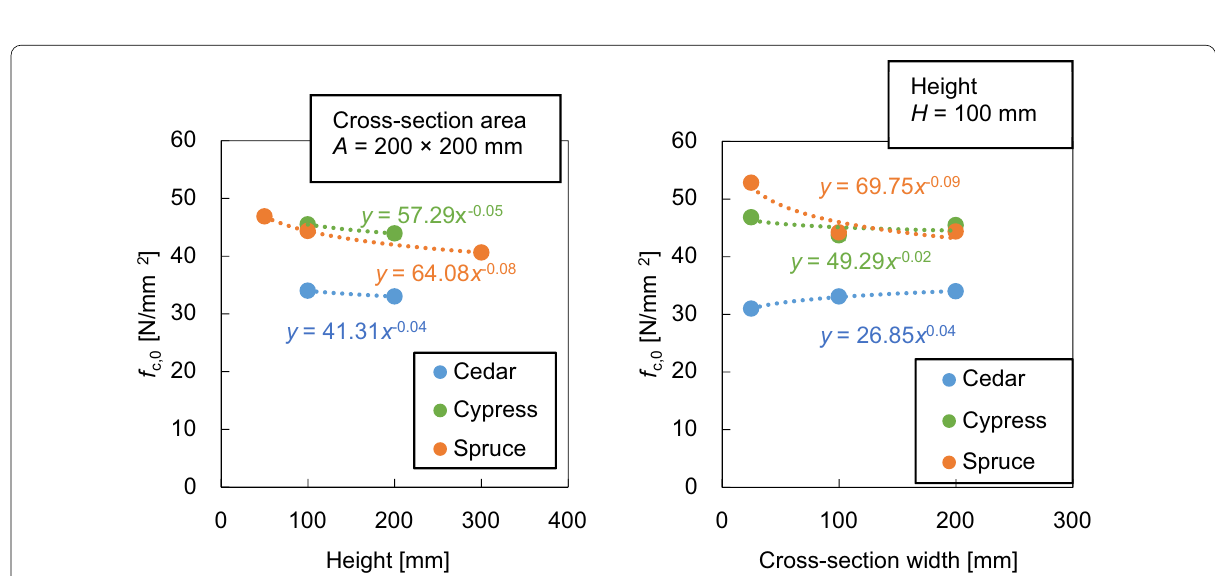
Fig. 7 Influence of heights and widths of loaded area on values of f